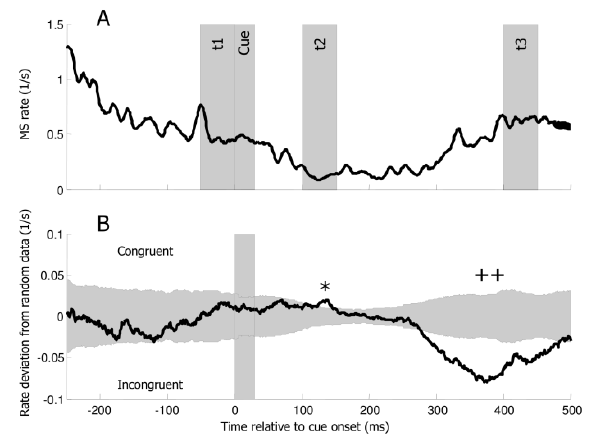
Figure 3. The modulation of microsaccade rates during fixation in a visual non-predictive cue-target task. Average microsaccade rate is plotted relative to cue onset (A). t1, t2 and t3, refer to time epochs chosen to analyze changes in rate after stimulus presentation. The rate deviation of congruent and incongruent microsaccades from randomized data is also plotted (B). Congruency refers to cue and microsaccade direction. The shaded area represents two standard deviations from the mean of 100 randomized data sets. Hence, when the rate deviation is greater than or larger than the shaded area, the deviation is significant. Two significant deviations from the randomized